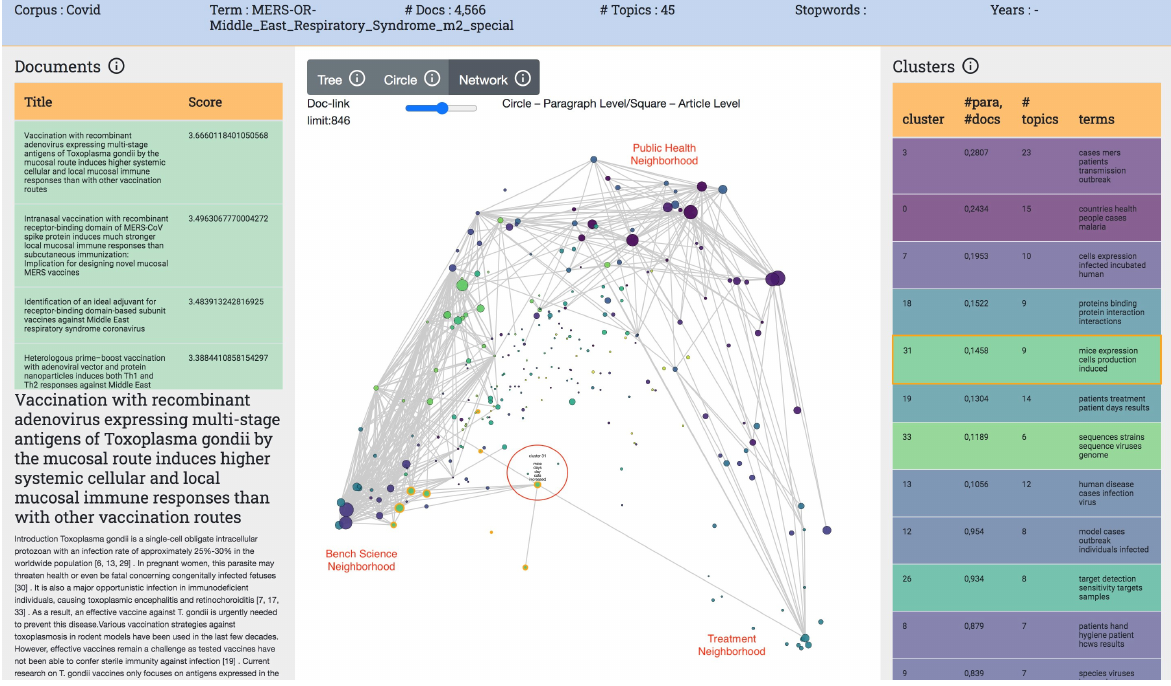
Figure 5. Network visualization of the MERS Topic Model excluding COVID-19